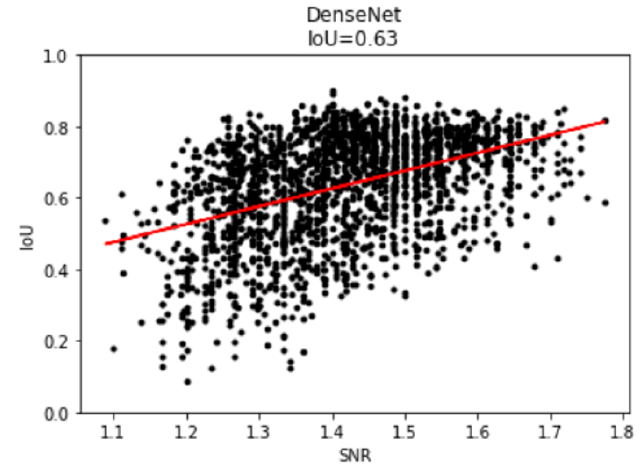
Figure 11. The scatter plot of IoU vs. SNR for all the